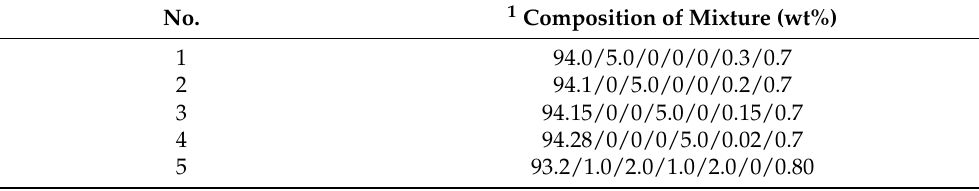
Table 1. Composition ratio of liquid crystal